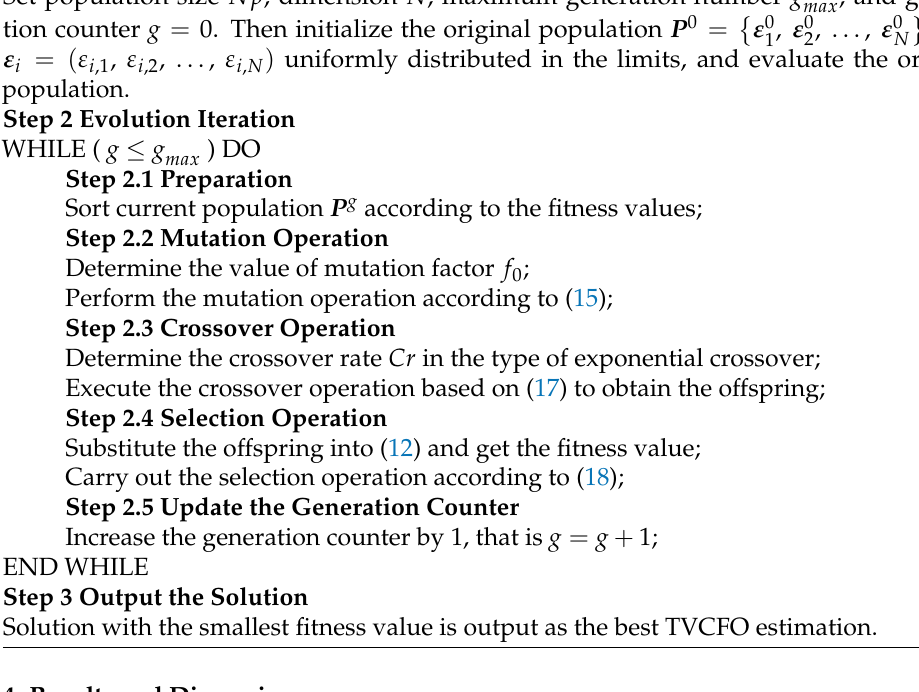
Algorithm 1 Pseudocode of the proposed